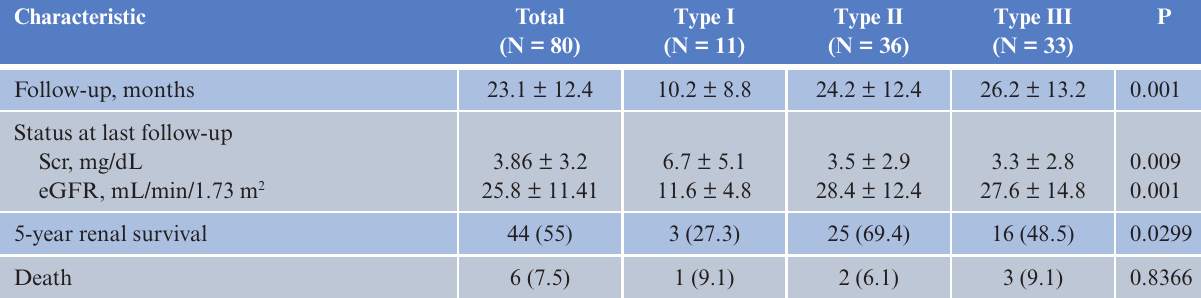
Table 5: Outcomes at follow-up for the study population.